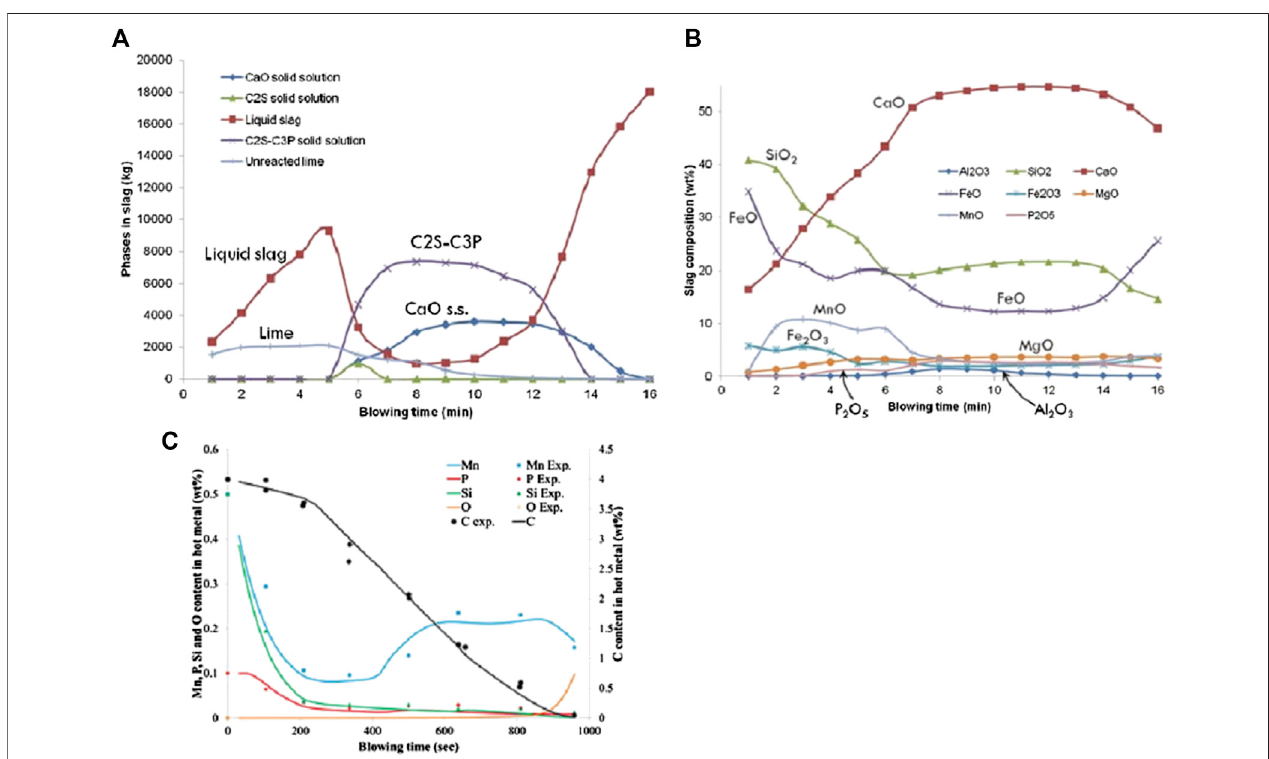
FIGURE 10 | Calculation results of (A) phases in the multi-phase slag and (B) compositions of the liquid slag and (C) validations of compositions in the metal bath (Jung et al., 2014; Van Ende and Jung, 2018) [Figure 8 of (Jung et al., 2014), Copyright The Omnipress; Figure 3.9 of (Van Ende and Jung, 2018), Copyright Springer International